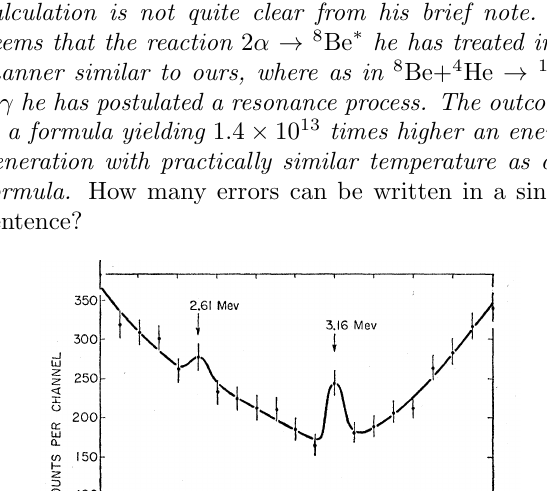
Figure 8.13: The status of the level structure of Figure 8.14: The clear evidence for the two groups